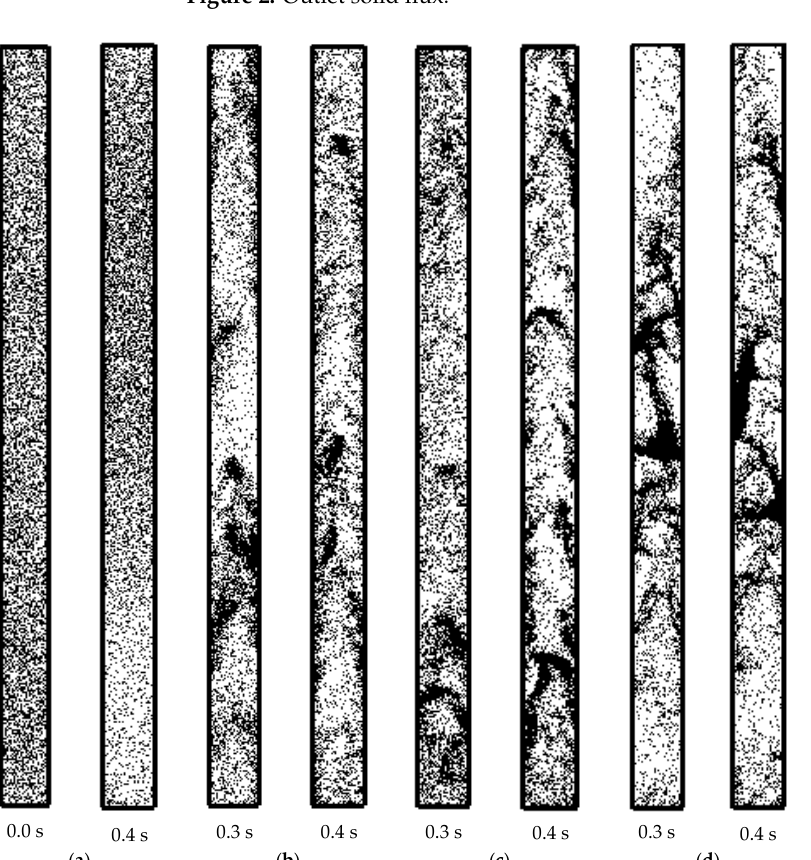
Figure 3. Outlet solid flux: ( a ) drag Model A, grid number 10 × 40; ( b ) drag Model B, grid number 10 × 40; ( c ) drag Model B, grid number 10 × 160; ( d ) drag Model B, grid number 20 × 320.